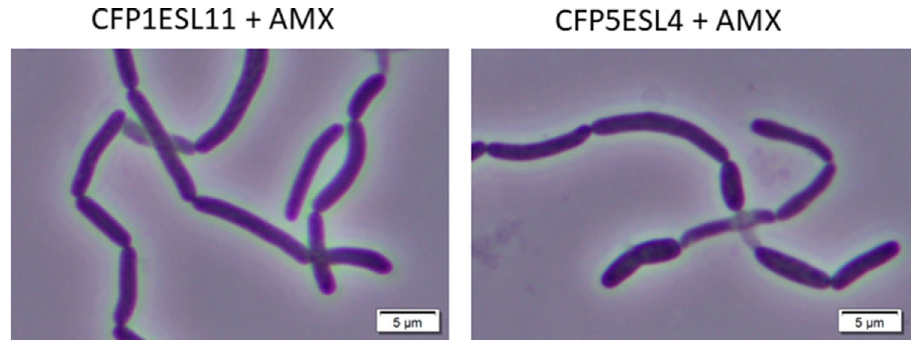
Figure 3. Cell shape of cefoperazone-resistant clones carrying Slin_5958 mutation in the presence of the subinhibitory concentration of amoxicillin. Microscopy of the CFP1ESL11 and CFP5ESL4 strains treated with the subinhibitory concentration (0.78 μg/mL) of amoxicillin. Bar, 5 μm. Cells were cultivated in the stationary phase in Spirosoma medium containing a subinhibitory concentration of amoxicillin at 26 °C with